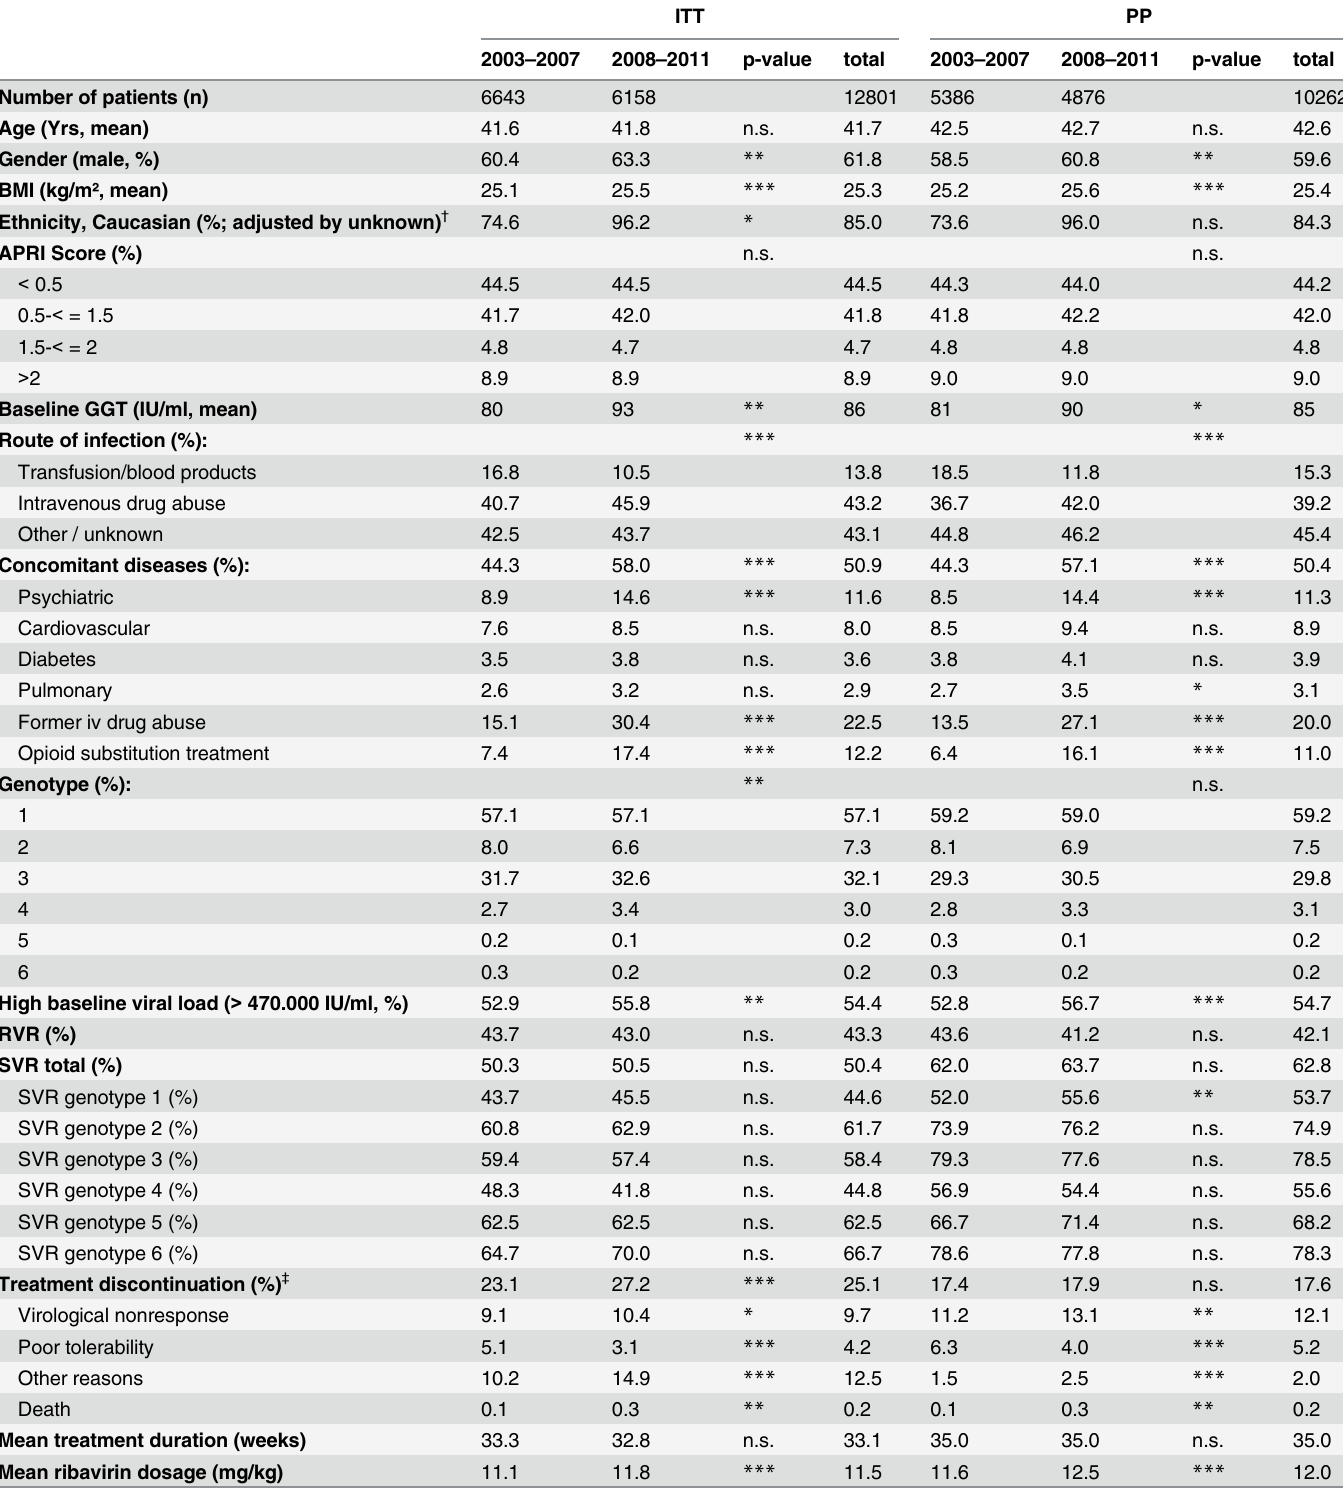
Table 1. Baseline demographics, virological responses, treatment discontinuations as well as treatment duration and mean ribavirin dose in the two treatment periods 2003 – 2007 and 2008 – 2011 in the ITT and PP